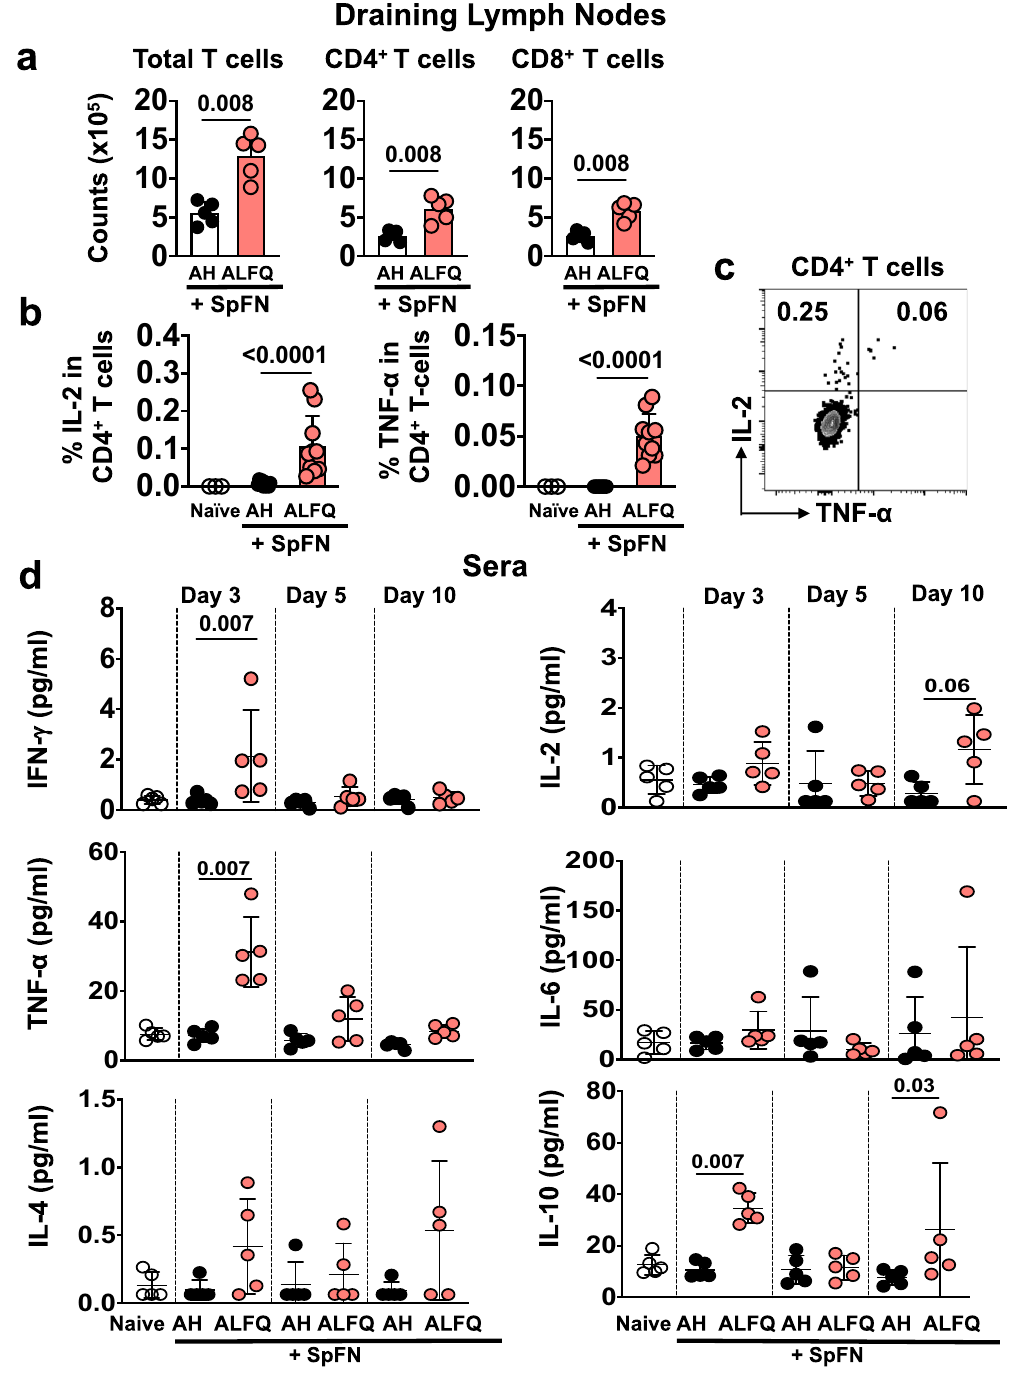
Fig. 2 T cell priming and cytokine pro fi le in the sera in response to SpFN vaccine. a Magnitude of the T cell response in the dLNs at day 7 post-priming vaccination ( n = 5 mice/group/time point). b Percentage of IL-2 expressing (left panel) and TNF- α expressing (right panel) SARS- CoV-2 spike-speci fi c CD4 + T cells in the dLNs 10 days post-vaccination, following stimulation with spike S1 peptide pool. Bars indicate mean + s.d. c IL-2 and TNF- α are co-expressed in the SARS-CoV-2 spike-speci fi c CD4 + T cells, indicating mainly a T H 1 type response. d Cytokine pro fi le in the sera of vaccinated mice as determined by multiplex ECLIA using Meso Scale Discovery (MSD) platform on days 3, 5, and 10 post- vaccination. Dots represent data from individual mice, horizontal lines represent mean, and error bars represent s.d. Experiments were repeated twice and differences between the two groups were analyzed by using a nonparametric Mann – Whitney U -test with p ≤ 0.05 considered as statistically signi fi phenotype in the IFN- γ + CD4 + T cells responsive to the S1 (CD69 + CD44 + and CD62L − CD103 − ; Supplementary Fig. 2e, f ) . Furthermore, IFN- γ and TNF- α were dominant and co-expressed peptide pool showed a predominance of T EM suggesting strong by both spike-speci fi c CD4 + and CD8 + T cells in the SpFN + ALFQ stimulation through the T cell receptor during priming 45 (Supple- vaccine group (Fig. 4c). Characterization of the memory mental Fig. 2g).